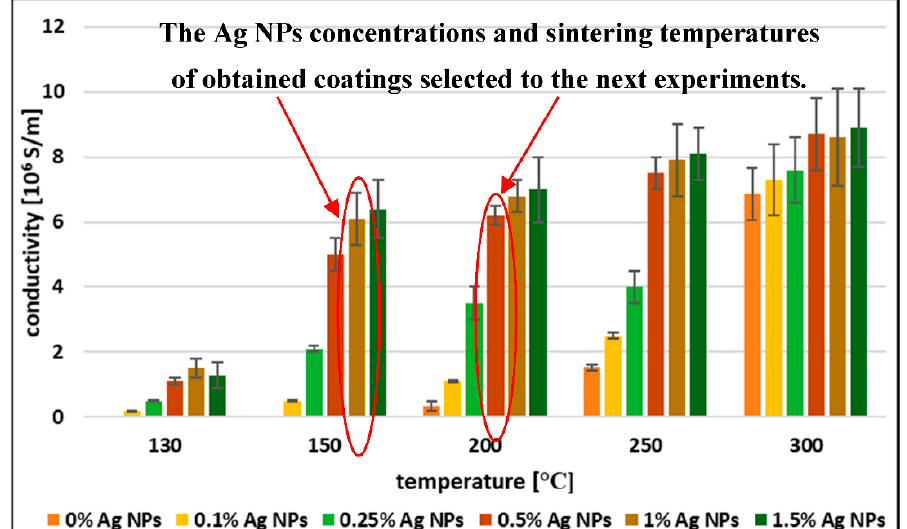
Figure 5. The dependence of the conductivity of metallic films based on Ni-Ag NPs (main filler) on the doped concentration of Ag NPs and sintering temperature (heating duration 30 min).